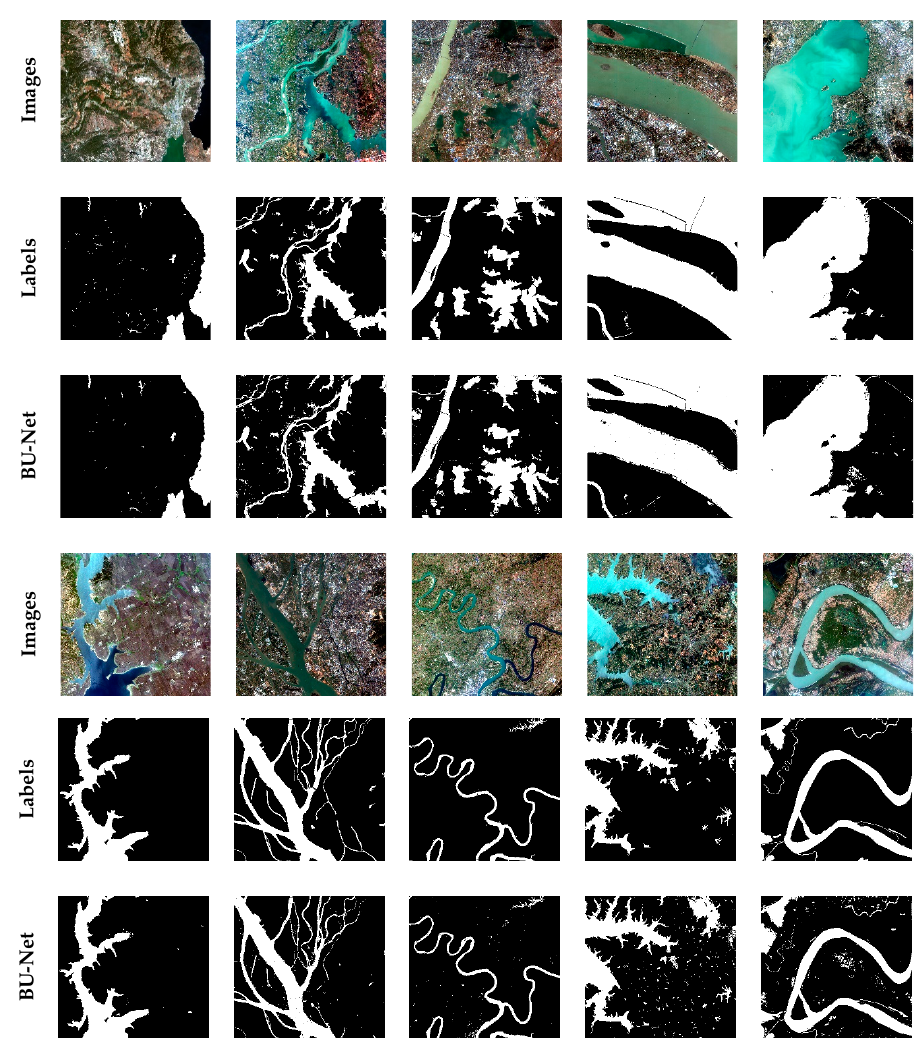
Figure 3. Prediction results of ten validation images.